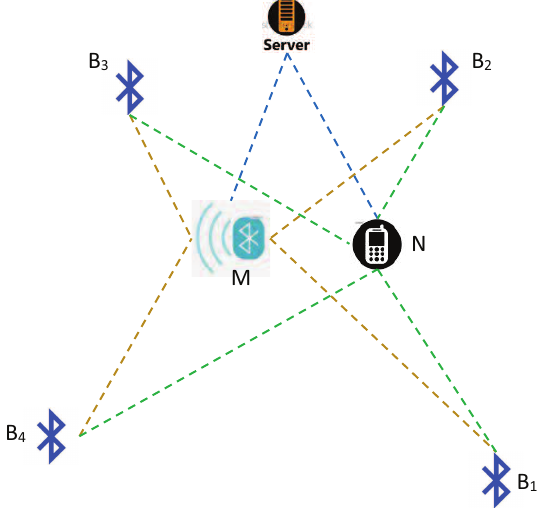
Figure 3. Diagram of indoor positioning by Bluetooth nodes with received signal strength indication (RSSI)